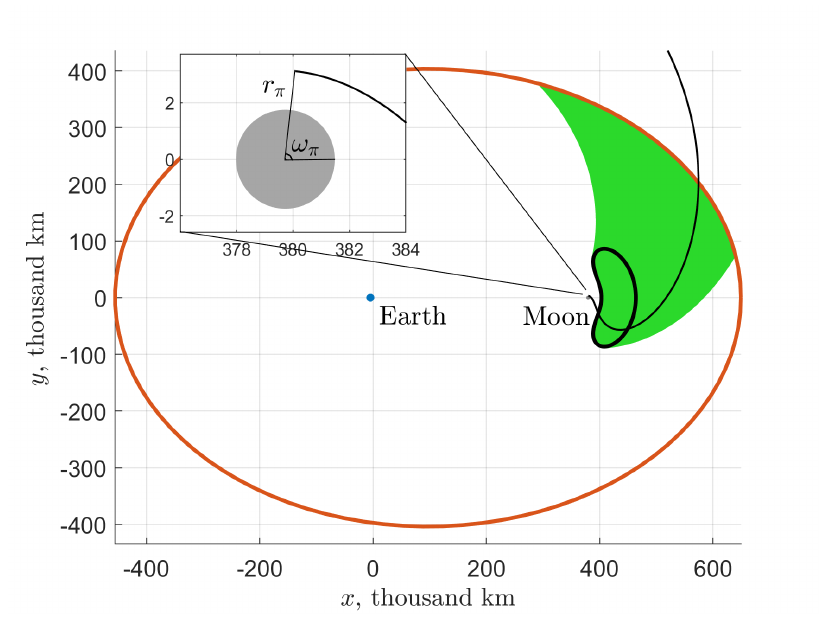
Figure 6. Sample ballistic capture trajectory with the closest lunar approach of 1403 km ( r π = 3141 km) at a point with ω π = 83.5 deg. The Jacobi integral value equals J = 3.06 along the capture trajectory.